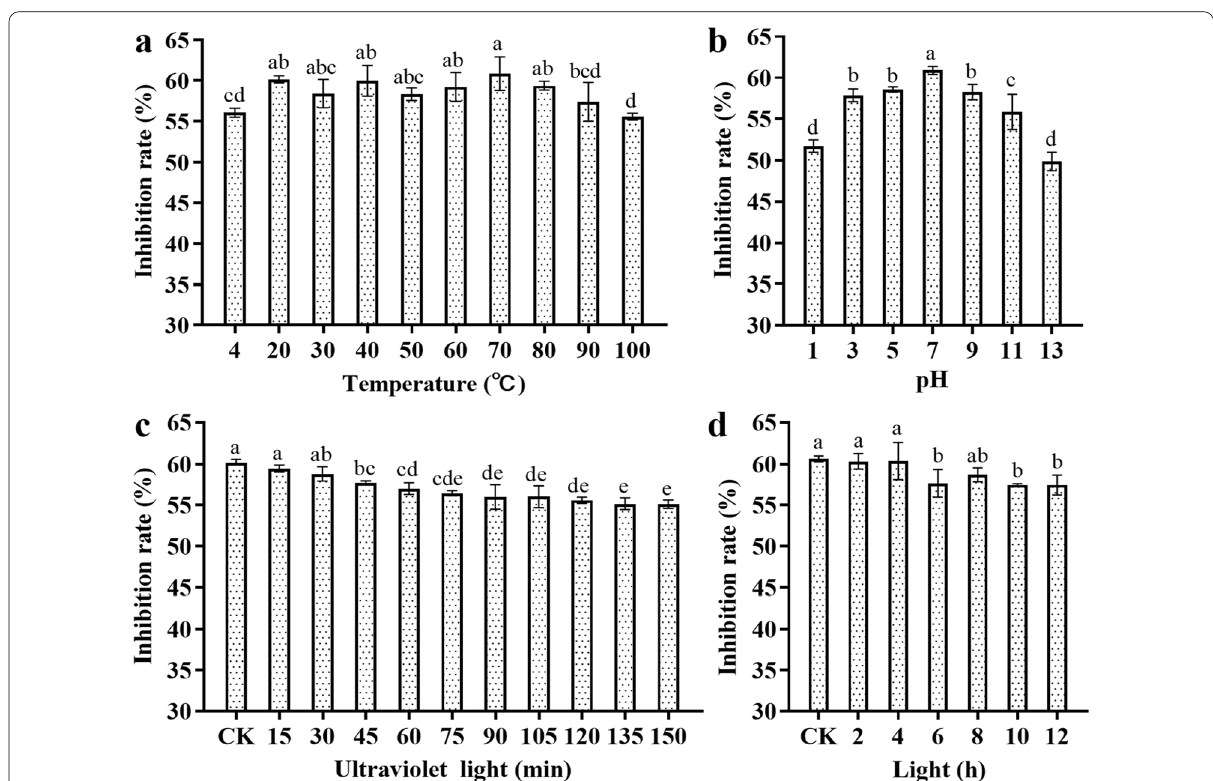
Fig. 4 Inhibition rates of compound fermentation supernatants (CFS) under different treatments. a Temperature; b pH; c Ultraviolet light; d Light. Different letters in the figures indicate significant differences ( P <